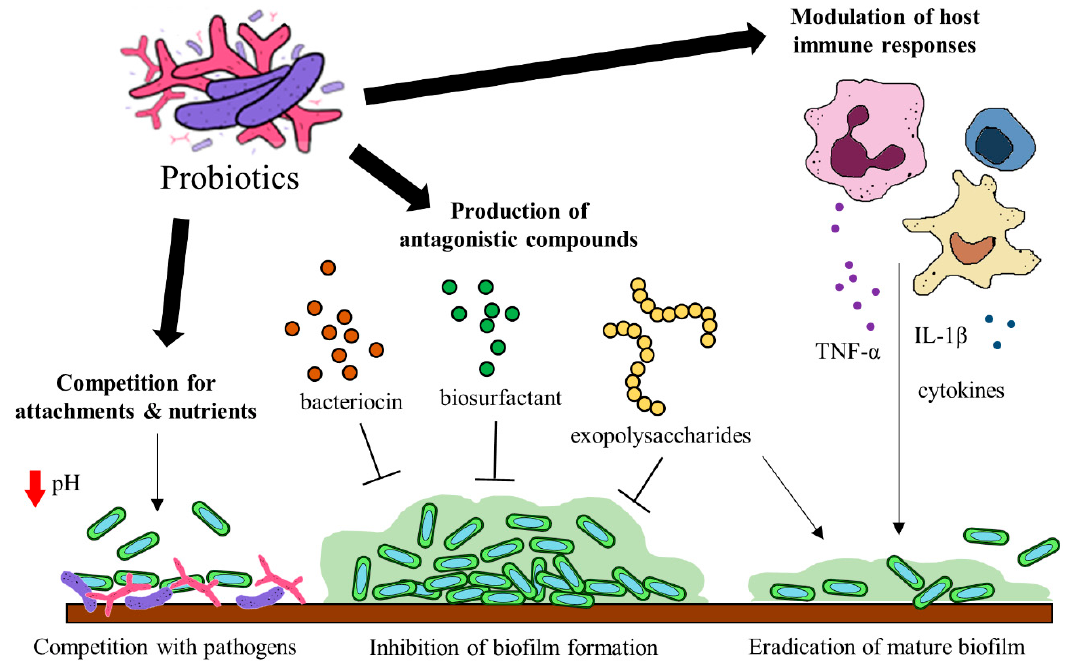
Figure 2. Potential mechanisms of probiotics to target gut microbial biofilms.